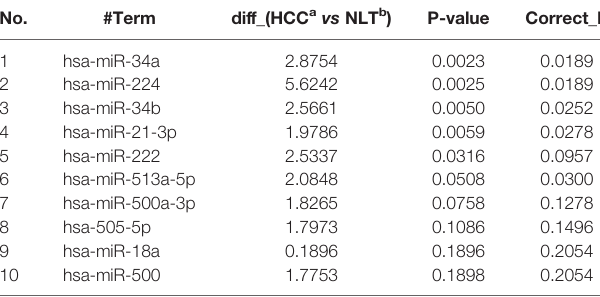
TABLE 2 | Levels of miRNA expression in all three HCC cases and corresponding normal liver samples (top 10 listed here). No. #Term diff_(HCC a vs NLT b ) P-value